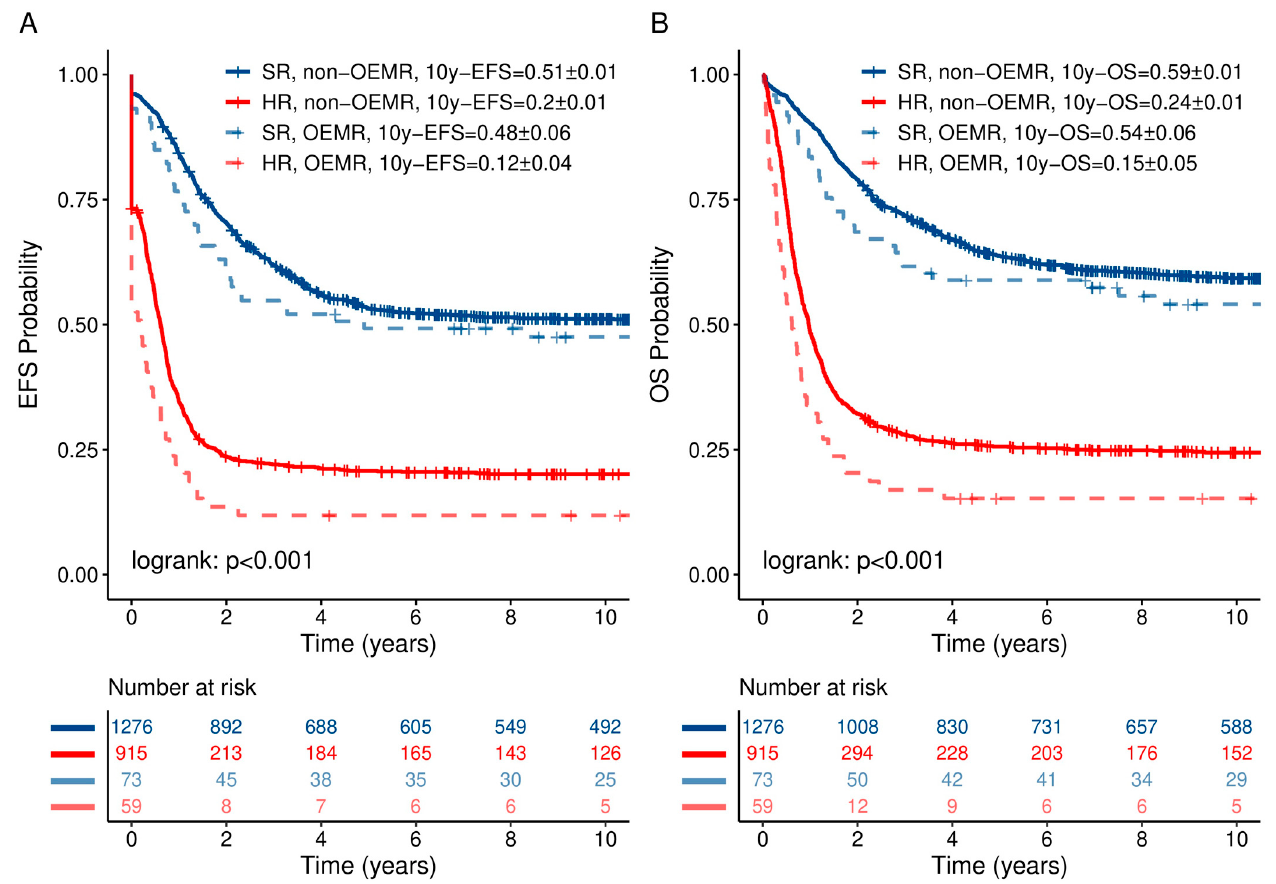
Figure 2. Ten-year pEFS (A) and pOS (B) of SR vs. HR patients differ significantly in OEMR and non-OEMR patients. The graphs have been calculated based on Kaplan–Meier analysis. Pairwise log-rank test applied in subgroup analysis. p < 0.001.